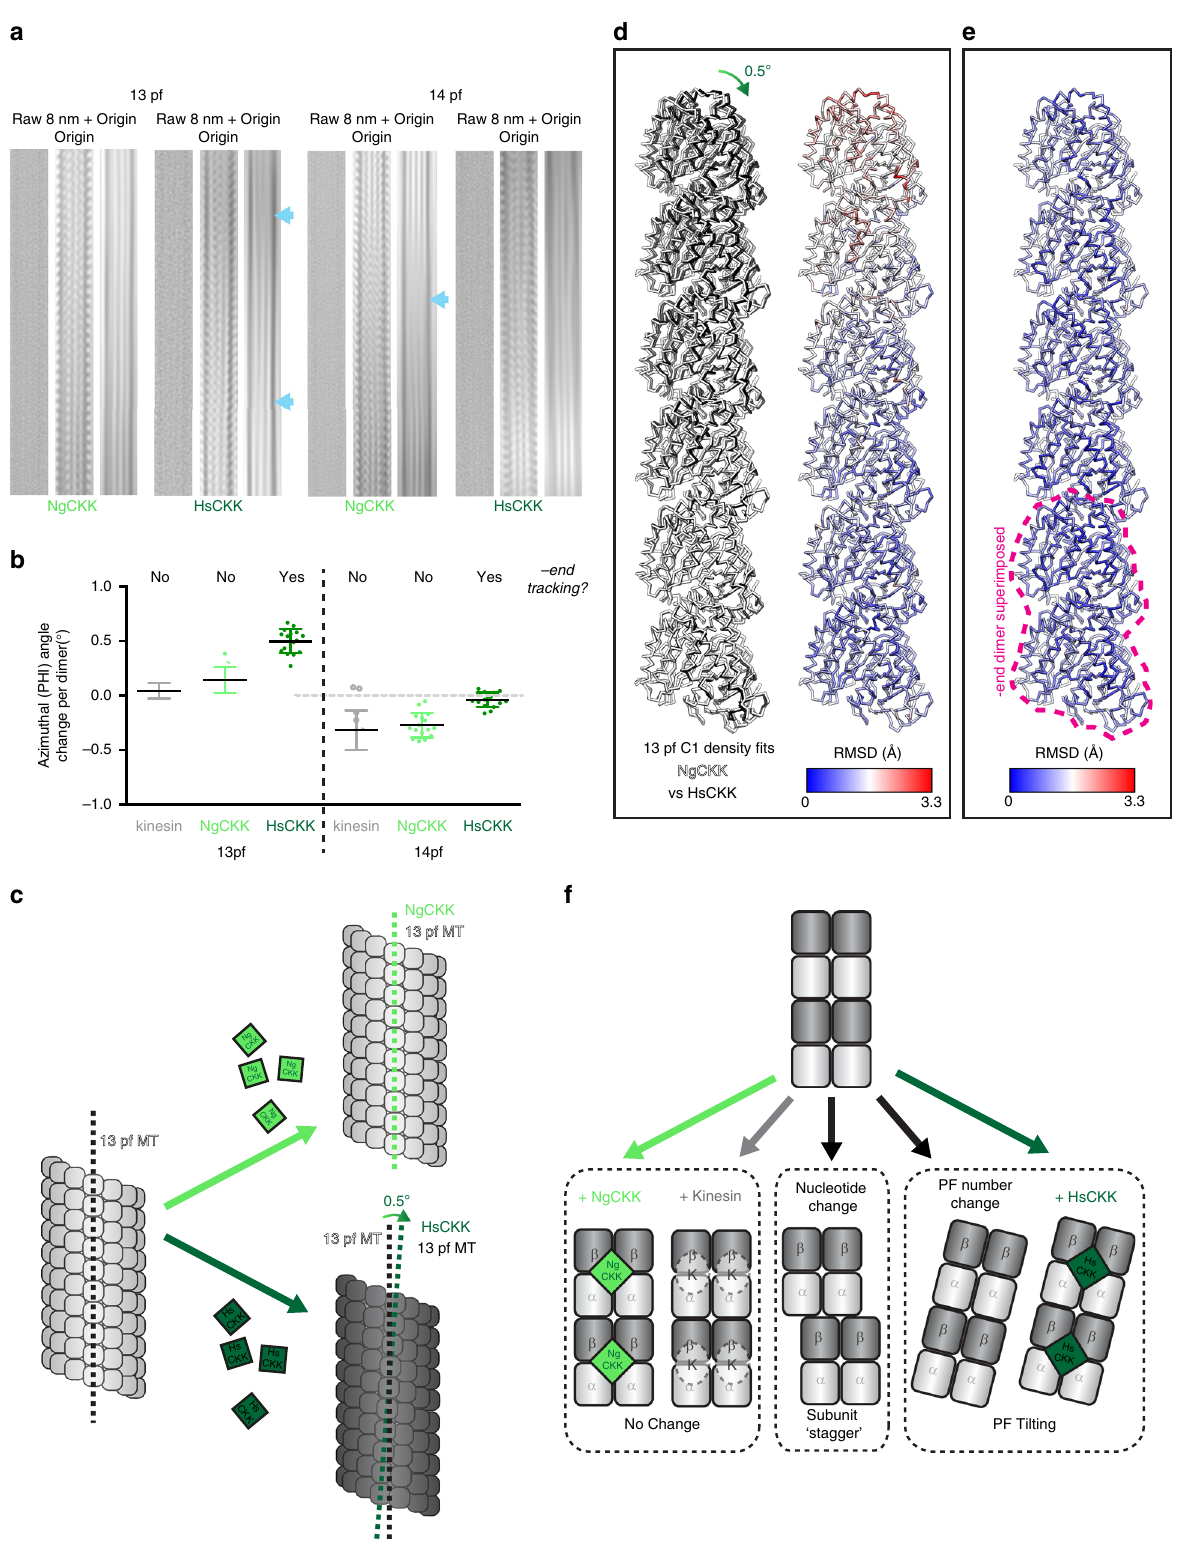
proto fi laments exhibit compression, shear and skew while con- serving the B-lattice MT architecture with a single seam predicted by the lattice accommodation model. The fi rst important aspect of the MT minus-end recognition mechanism by HsCKK revealed by our current data is that the CKK domain itself does not fl exibly respond to different